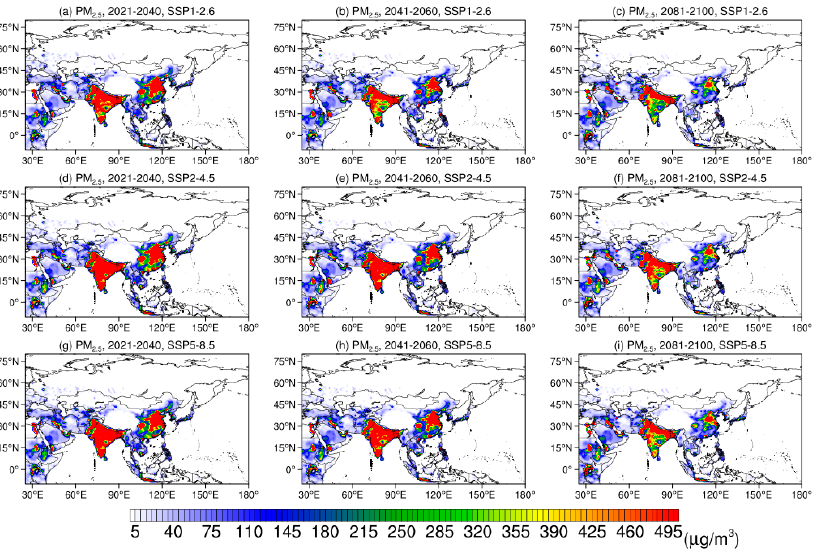
Figure 8. Spatial distribution of population-weighted annual mean surface PM 2.5 concentrations (units: µg/m 3 ) during 2021–2040, 2041–2060, and 2081–2100 under SSP1-2.6, SSP2-4.5, and SSP5-8.5.